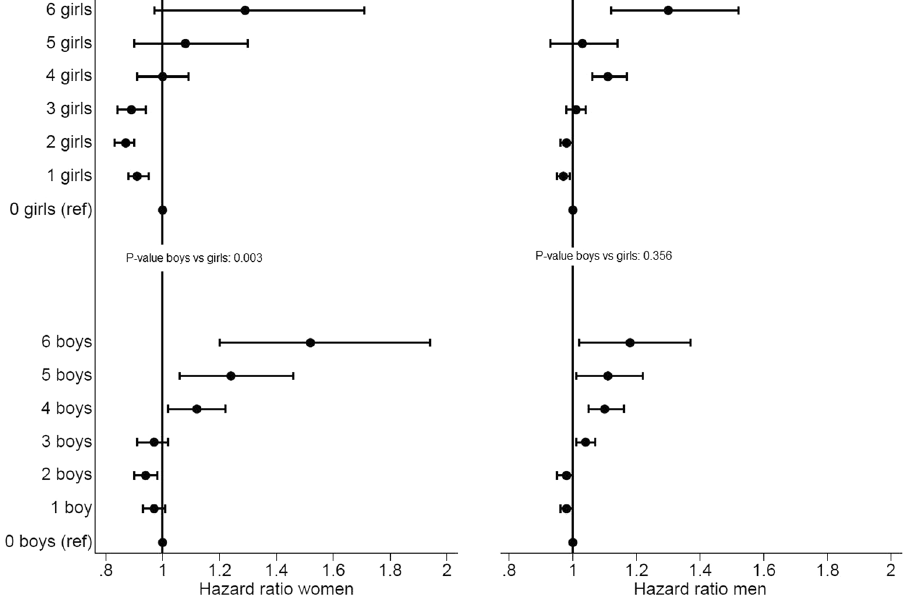
Figure 1. Age adjusted hazard ratio of cardiovascular mortality by number of offspring boys and girls among women (n = 661,013) and men (n =